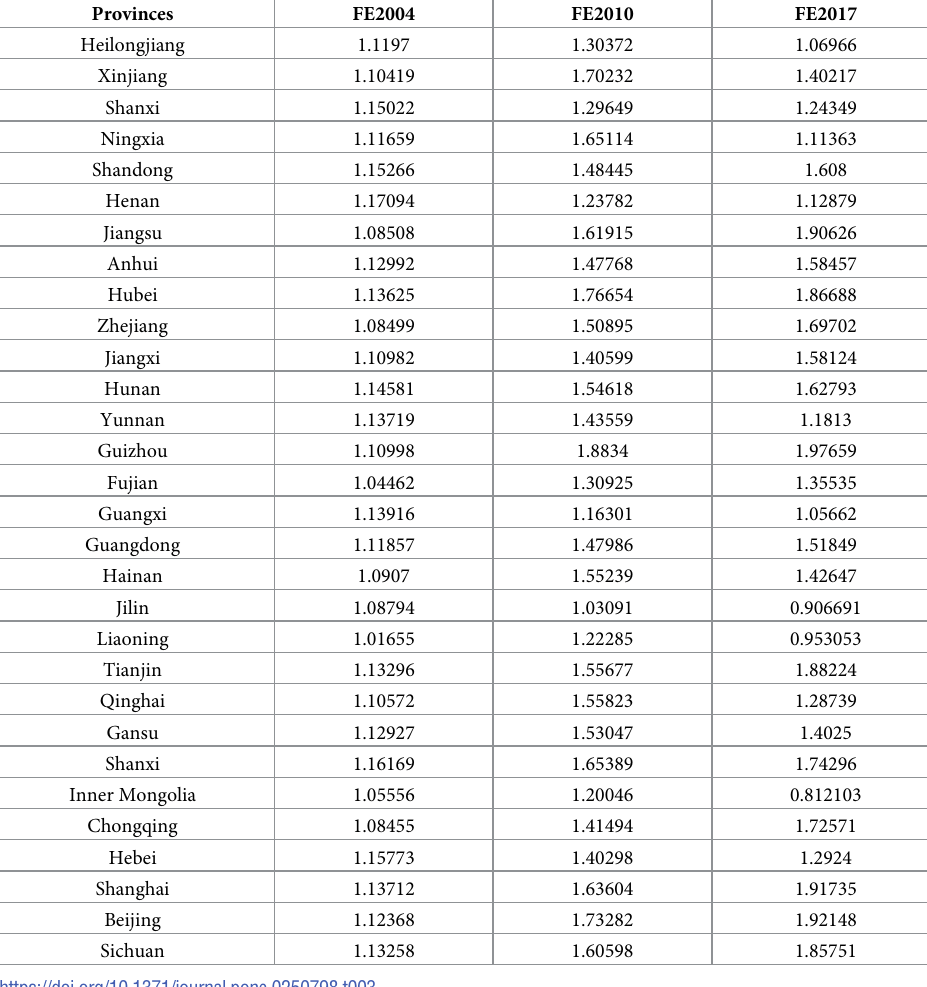
Table 3. China’s provincial FE in 2004, 2010 and